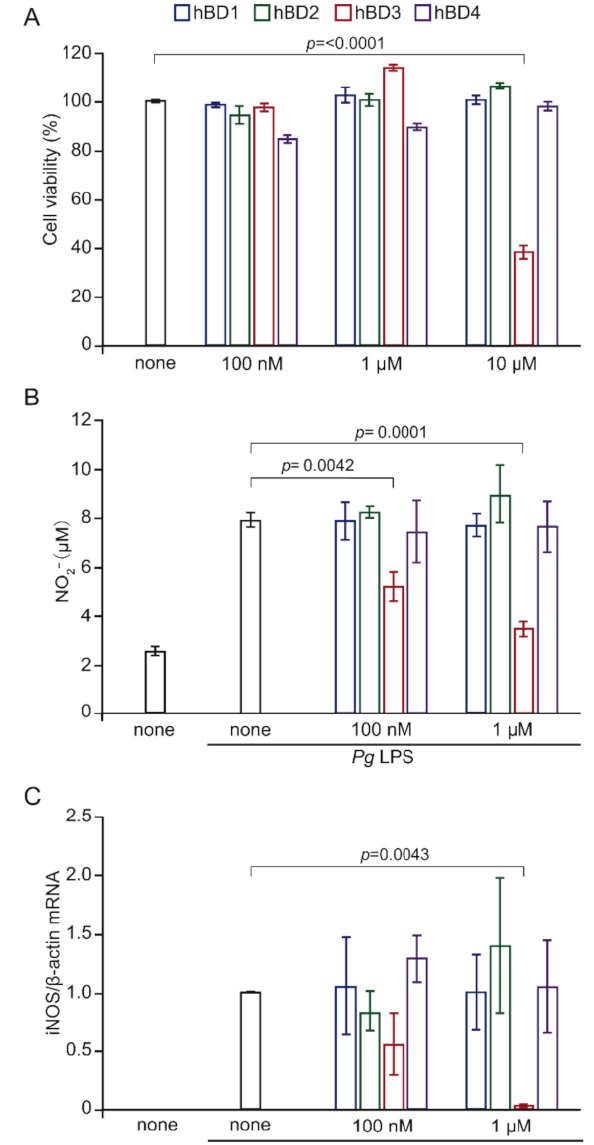
Figure 1. Effect of hBDs on cell viability, NO production and iNOS expression in MG6 cells after treatment of Pg LPS. ( A ) Cell viability of MG6 cells was evaluated using CCK-8 assay at 26 h after treatment with hBDs. MG6 cells were incubated with hBD1, 2, 3 and 4 with the concentrations ranging from 100 nM to 10 µ M. ( B ) the mean level of nitrite, the major NO metabolite, was measured by the Griess assay. MG6 cells were pre-treated with hBDs at the indicated concentrations (100 nM and 1 µ M) for 2 h and then treated with Pg LPS (10 µ g/mL) for 24 h. C . The mean mRNA expression level